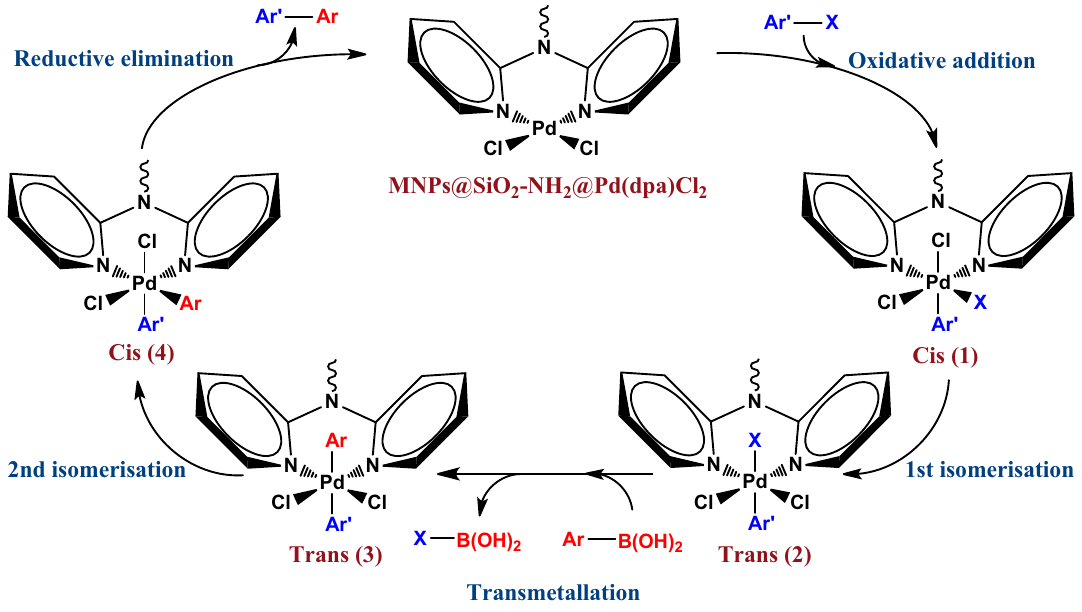
Figure 5. Proposed mechanism of the Suzuki–Miyaura cross-coupling reaction employing MNPs@SiO 2 -NH 2 @ Pd(dpa)Cl